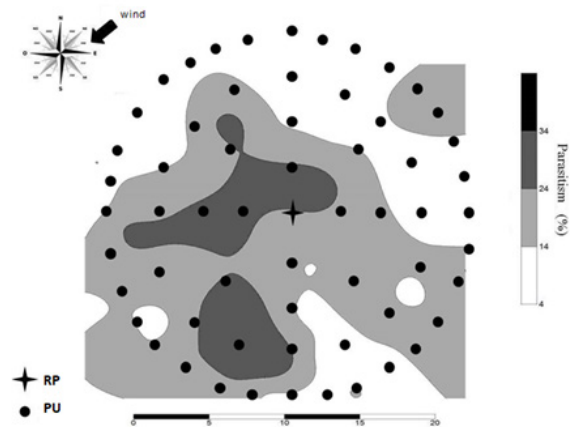
Figure 7. Spatial arrangement of parasitism units (PU), parasitoid release point (RP), wind direction (NO and 1.4 m/s) and interpolation of Trichogramma pretiosum (Hymenoptera: Trichogrammatidae) parasitism on Anagasta kuehniella eggs (Lepidoptera: Pyralidae) in cucumber.